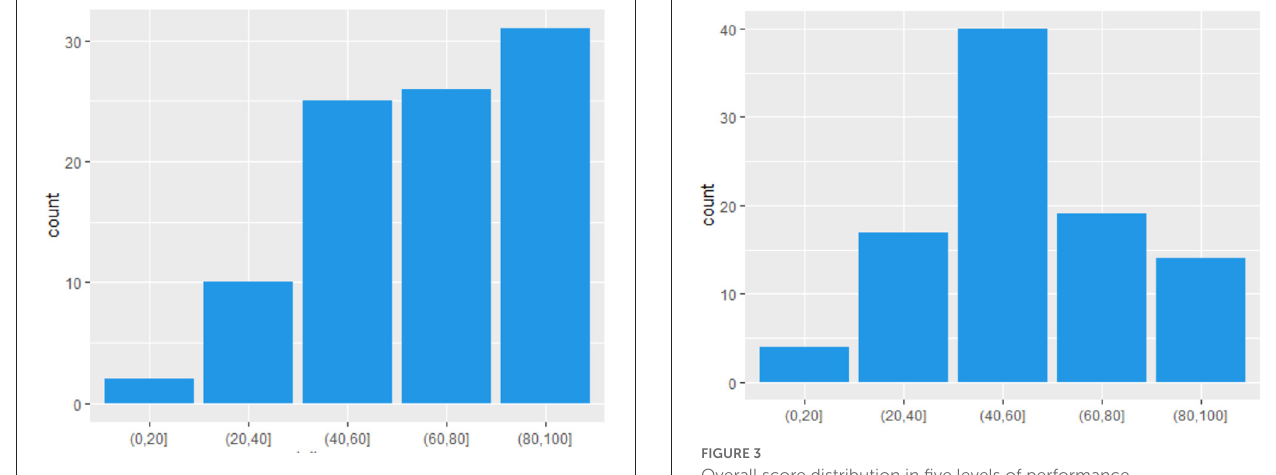
FIGURE2 Score distribution of delivery in five levels of performance.